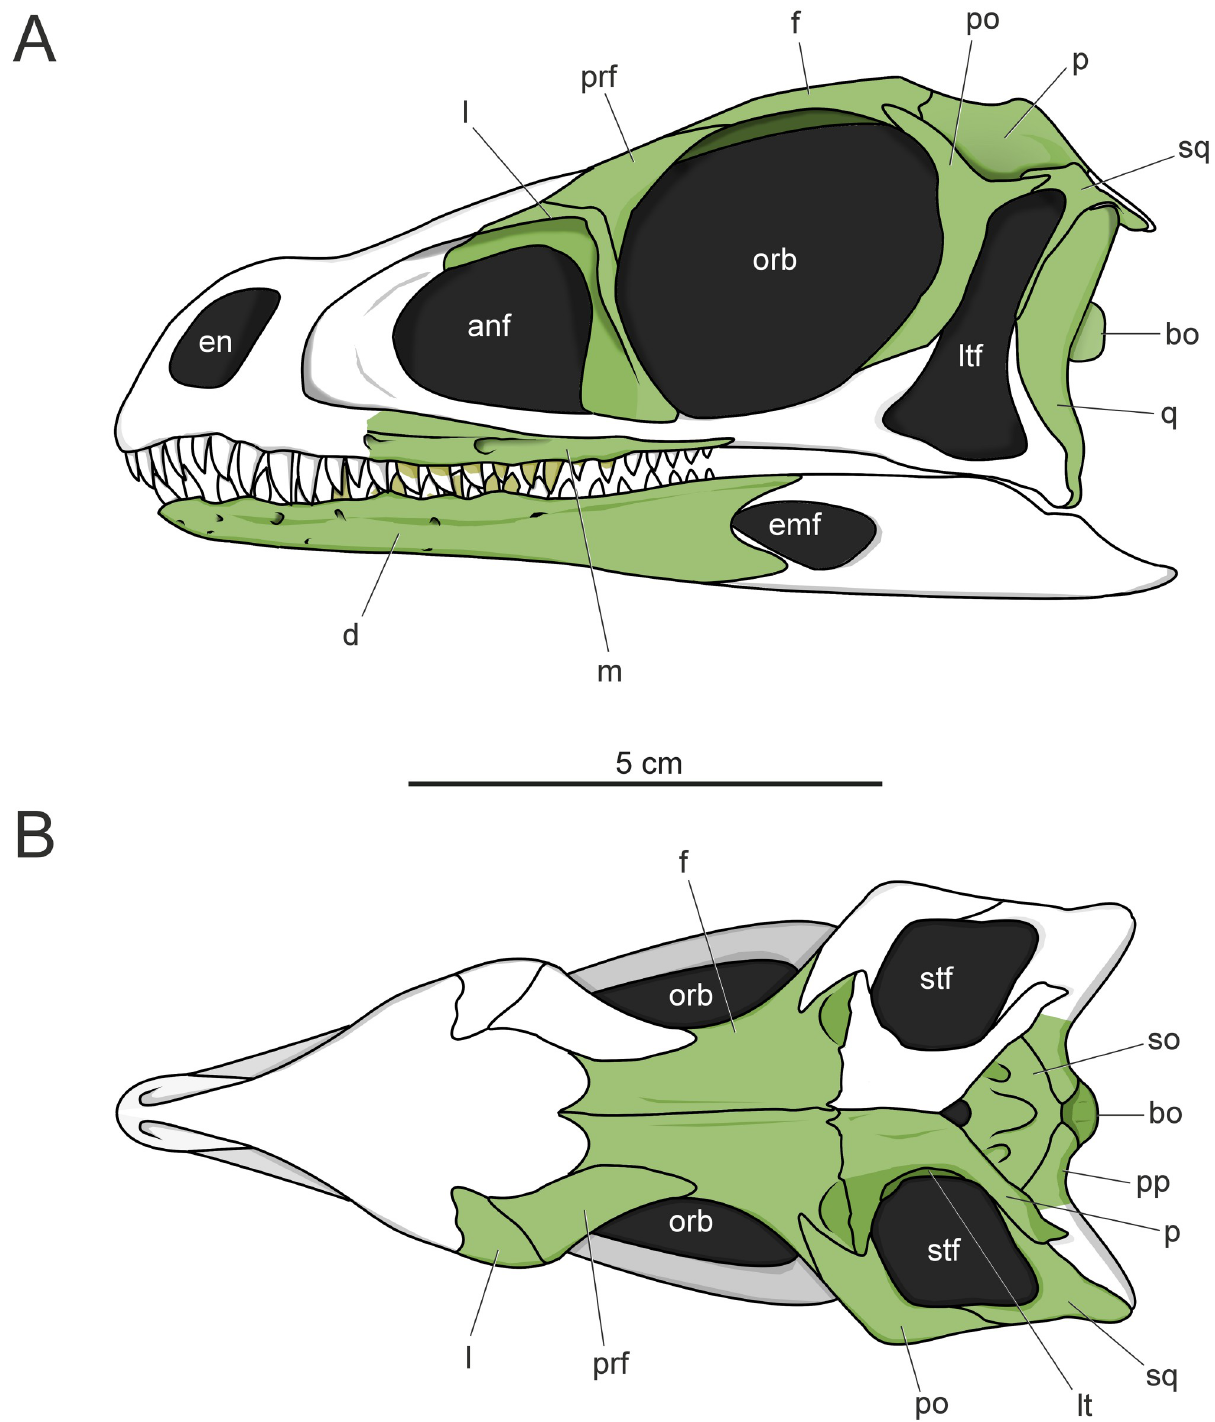
Fig 15. Reconstruction of the skull of Saturnalia tupiniquim in lateral (A) and dorsal (B) views, with preserved bones highlighted in green. Abbreviations: anf— antorbital fenestra; bo— basioccipital; d— dentary; emf— external mandibulary fenestra; en— external naris; f— frontal; l— lacrimal; lt— laterosphenoid; ltf— laterotemporal fenestra; m— maxilla; orb— orbit; p— parietal; po— postorbital; pp— paroccipital process; prf— prefrontal; q — quadrate; so— supraoccipital; sq— squamosal; stf— supratemporal fenestra.